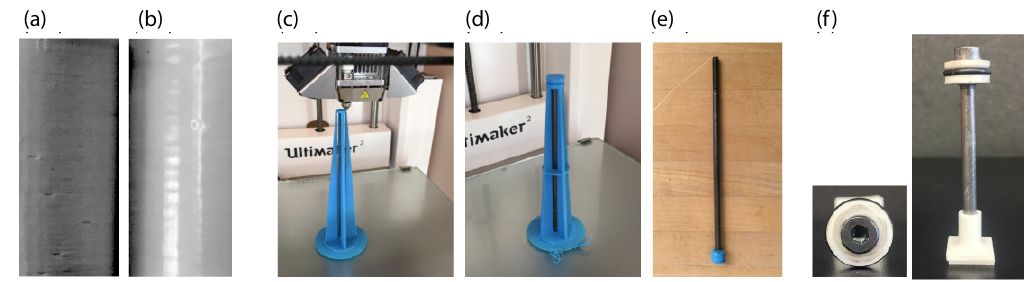
Figure 3. ( a ) Surface finish before and after ( b ) acetone treatment. ( c ) 3D printed scaffold followed by ( d ) bolt placement and printing the head and ( e ) bolt with piston head after removing the scaffold. ( f ) The 3D printed piston head is bonded to piston rod by an adhesive. The O-ring is manually placed in the groove on the piston